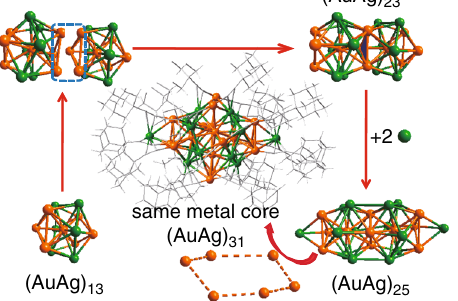
Fig. 2 Anatomy of the core structure of (AuAg) 34 and (AuAg) 34n . Colors: golden and green, Au/Ag; gray, C. All hydrogen atoms are omitted for clarity.